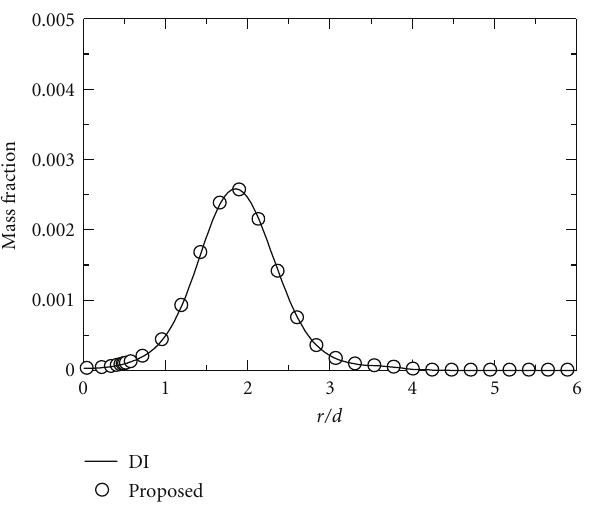
Figure 13: Axial mixture fraction.